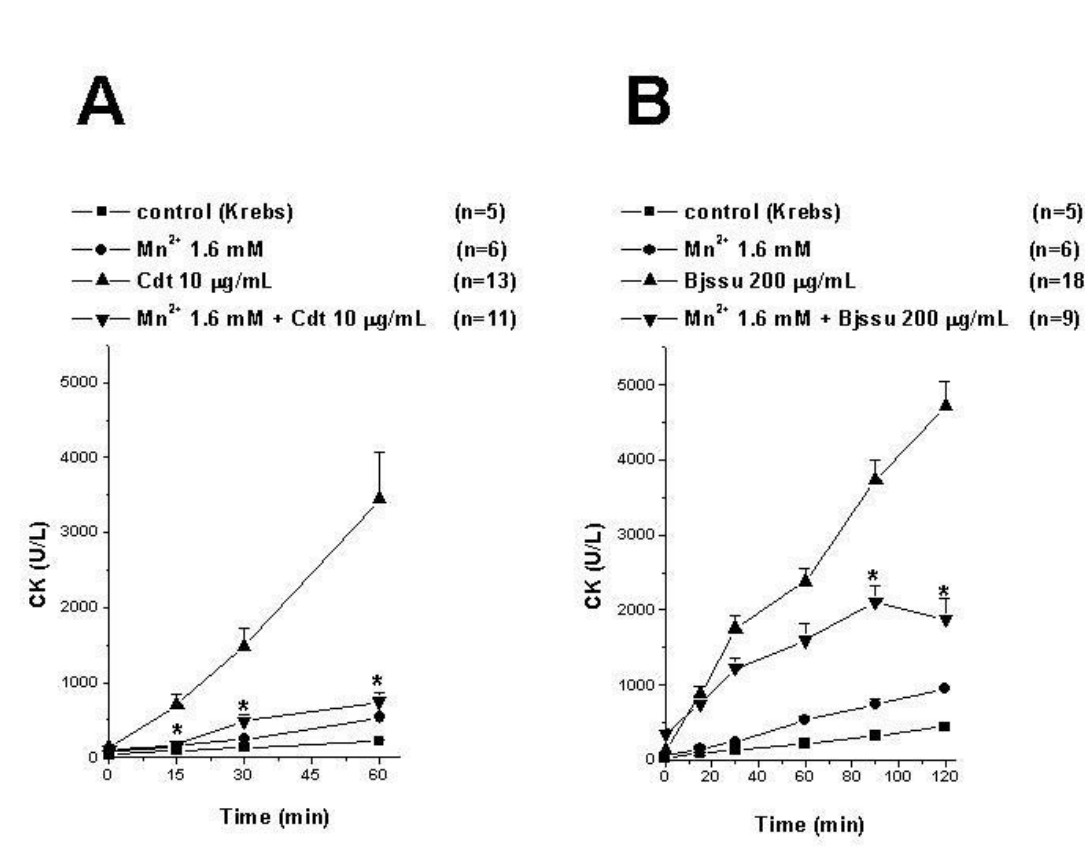
Figure 3. Creatine kinase (CK) activity in chick biventer cervicis preparations. ( A ) CK activity over 60min treatment with Crotalus durissus terrificus (Cdt) venom. ( B ) CK activity over 120min treatment with Bothrops jararacussu (Bjssu) venom. Each point represents the mean ± S.E.M. of the number of experiments indicated in parentheses. *p<0.05, compared with venoms